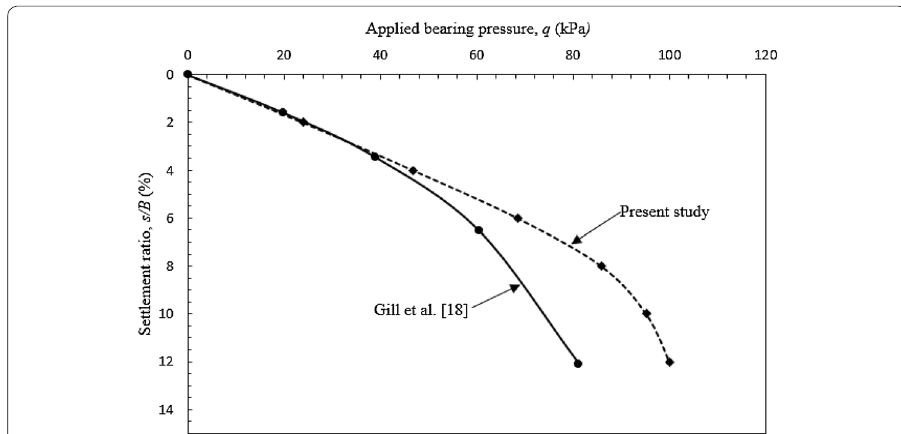
Fig. 3 Comparison of load‑settlement curves from Gill et al. [29] and the present study